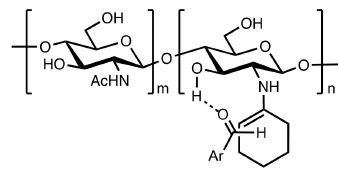
Scheme 137. Aldol reactions catalysed by chitosan 522 aerogel.